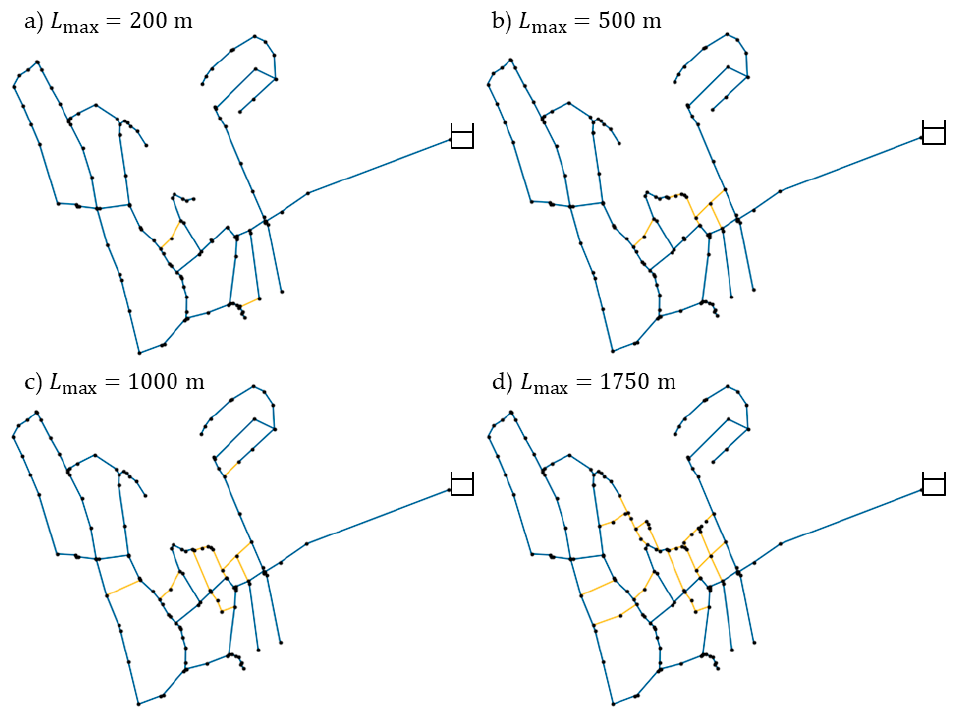
Figure 2. Optimal main line water distribution system adaptations for di ff erent optimization instances, di ff ering in the maximum length of added pipes L max for ( a ) 200 m, ( b ) 500 m, ( c ) 1000 m, and ( d ) 1750 m. The existing main line WDS is marked by blue edges while all chosen edges to be added are marked in yellow.